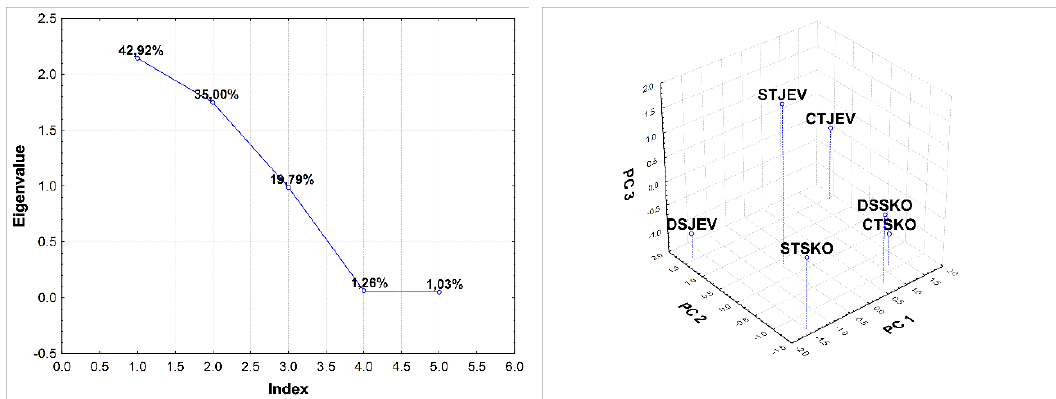
Figure 5. PCA of analysed parameters (Yield, Starch, NDF, OMD, Soil erosion) as affected by locality in the time period 2016–2018. Note: DM—Dry Matter, NDF—Neutral Detergent Fibre, OMD—Organic Matter Digestibility; CT—Conventional Tillage, ST—Strip-Till, DS—Direct Sowing; JEV—Jevicko, SKO—Skoupy.